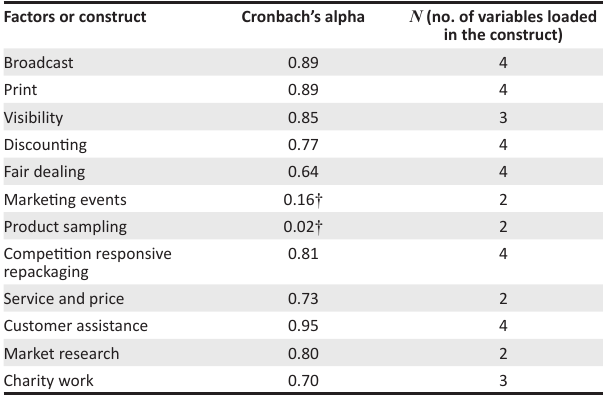
TABLE 3: Reliability coefficients of factors representing marketing communication